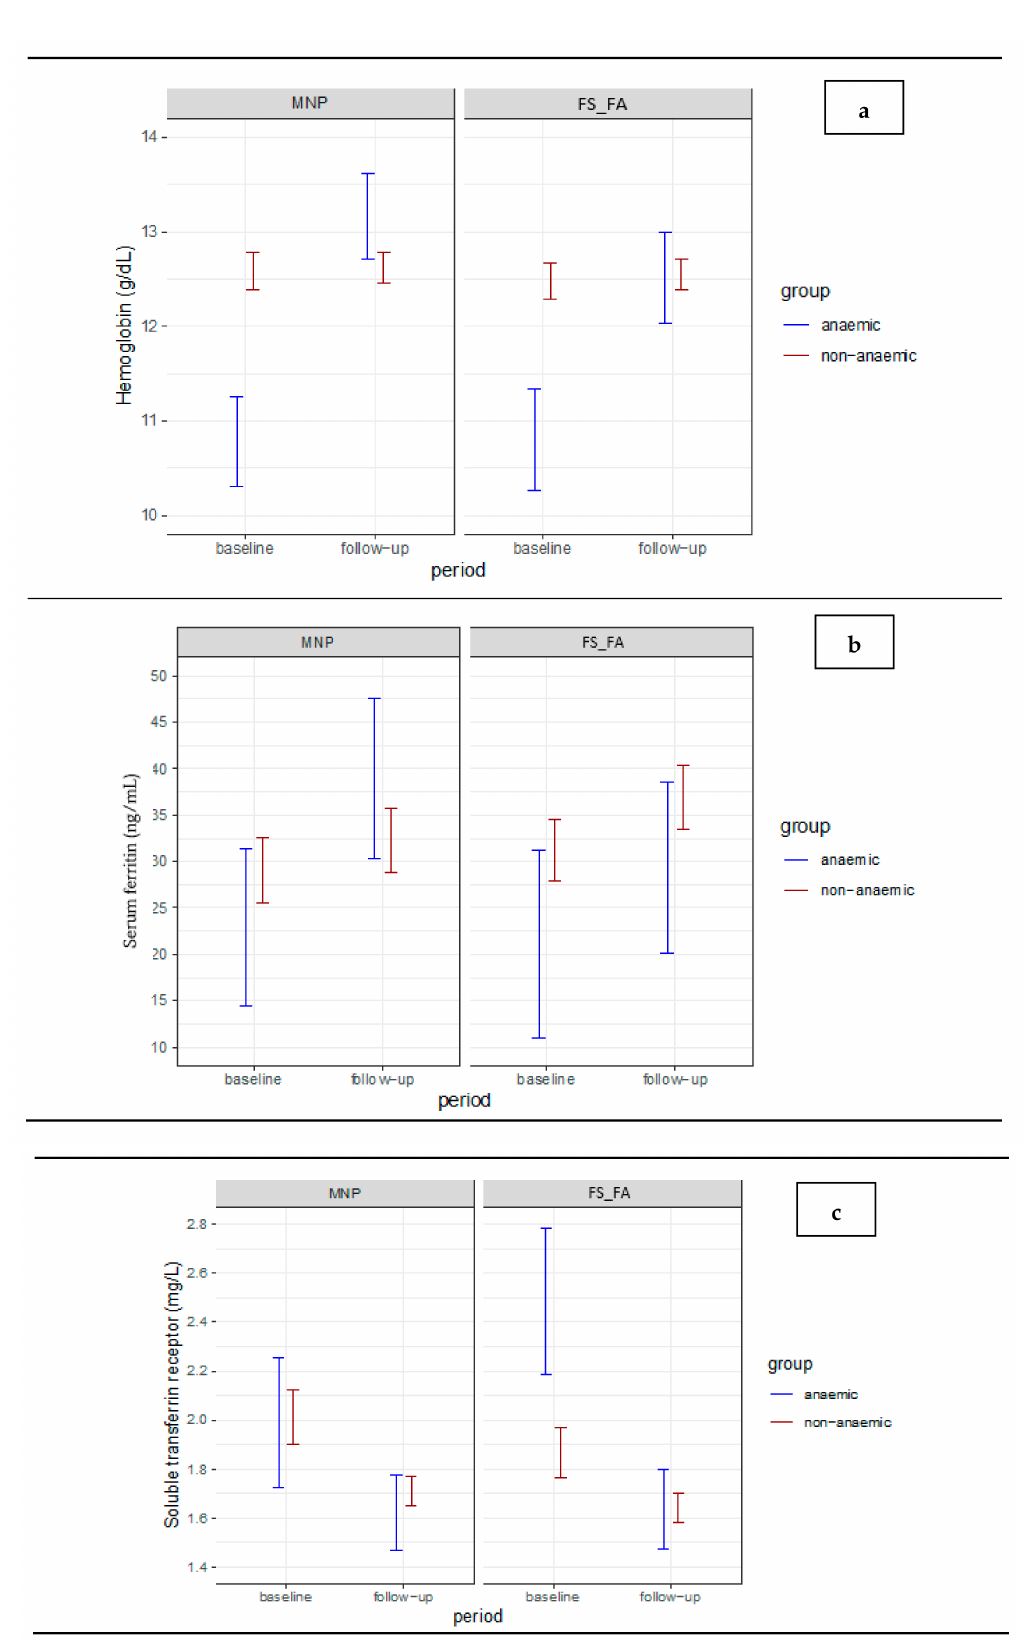
Figure 2. Average estimates of hemoglobin ( a ), serum ferritin ( b ), and soluble transferrin receptor ( c ) levels for each group and intervention in the two evaluation periods. Estimates of means with non-overlapping error bars differ statistically from each other, at a 5% level of